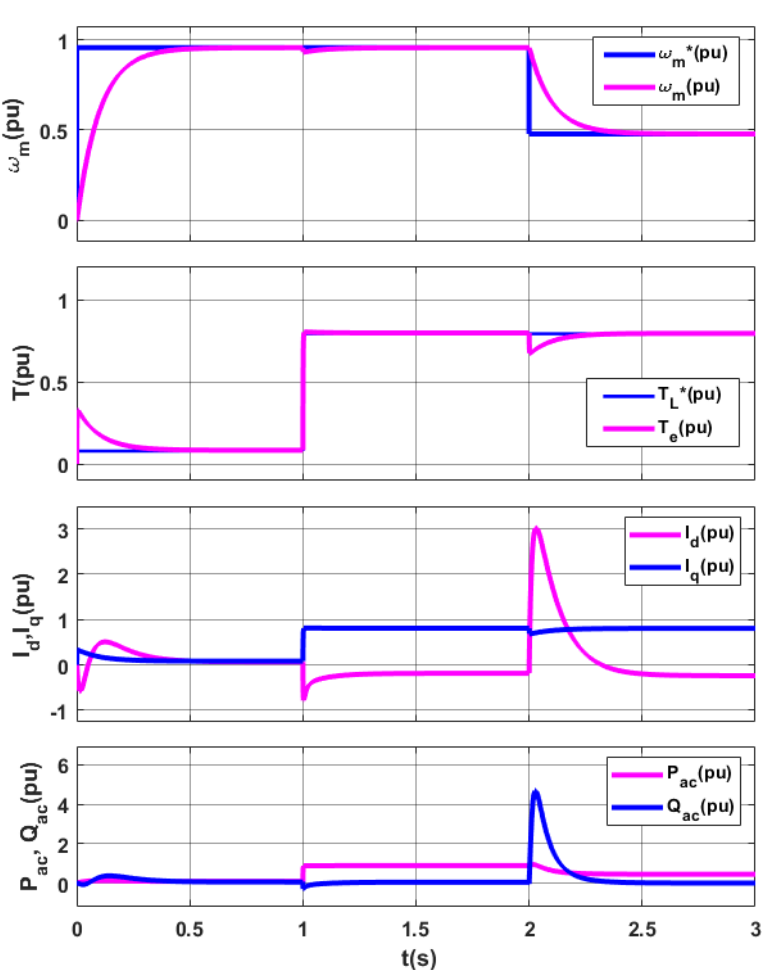
Figure 10. Energy processes (Pac, Qac) in the inverter-PMSM propulsion system during changes in speed and torque with energy optimization using the I/O linearization method.